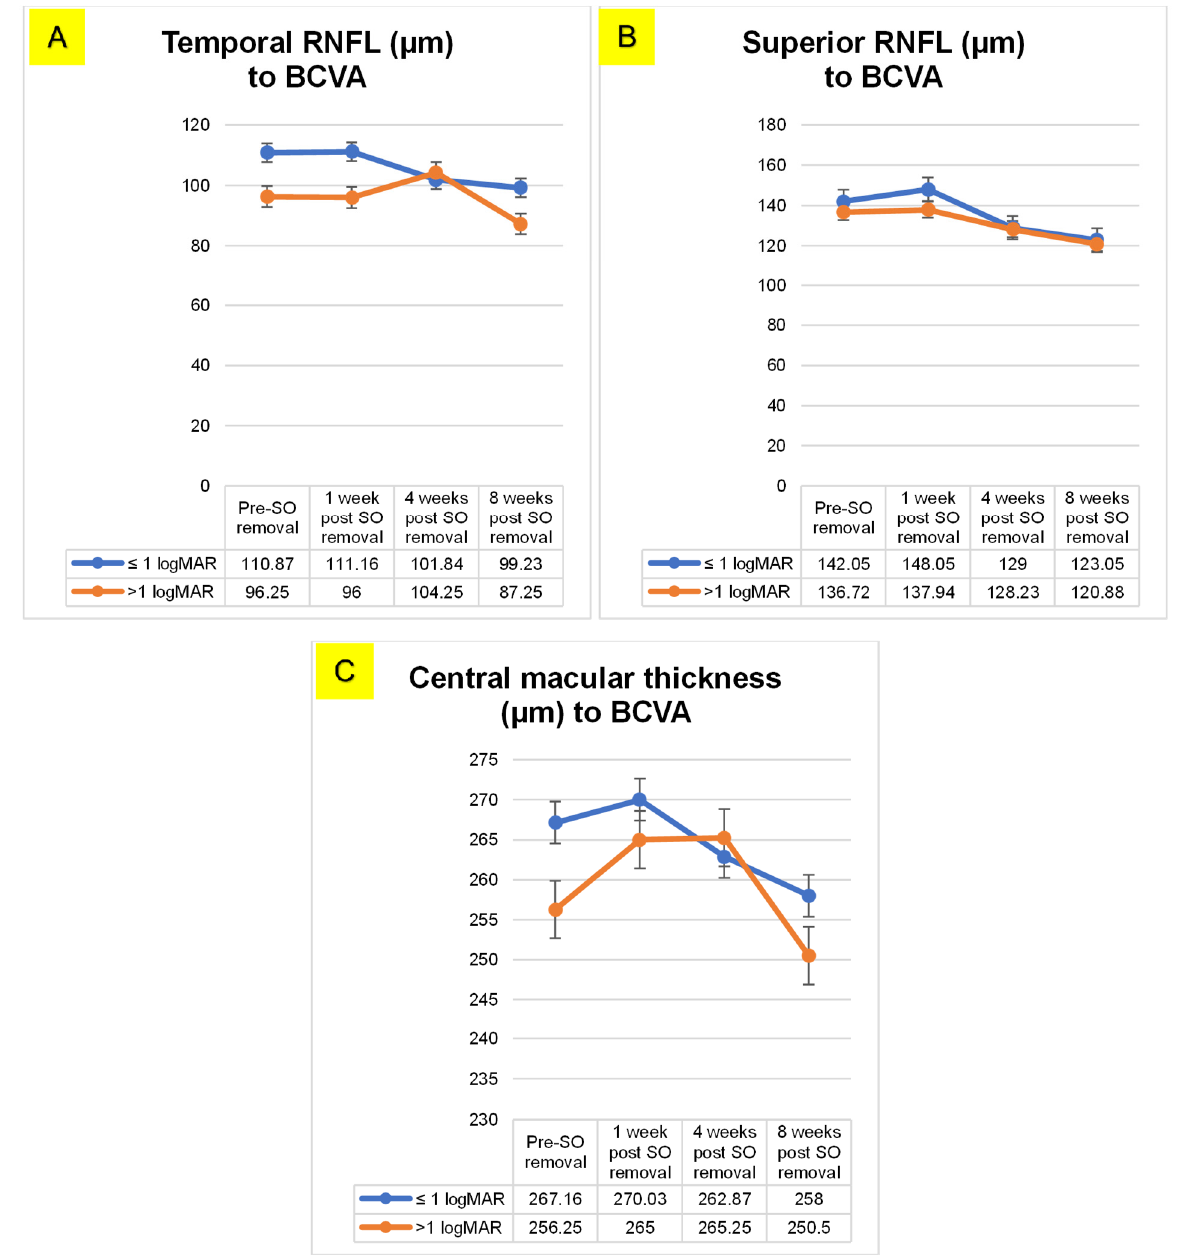
Figure 2. ( A ) Temporal RNFL thickness, ( B ) Superior RNFL thickness, and ( C ) Central Macular thickness of BCVA in rhegmatogenous retinal detachment patients pre- and post SO removal.